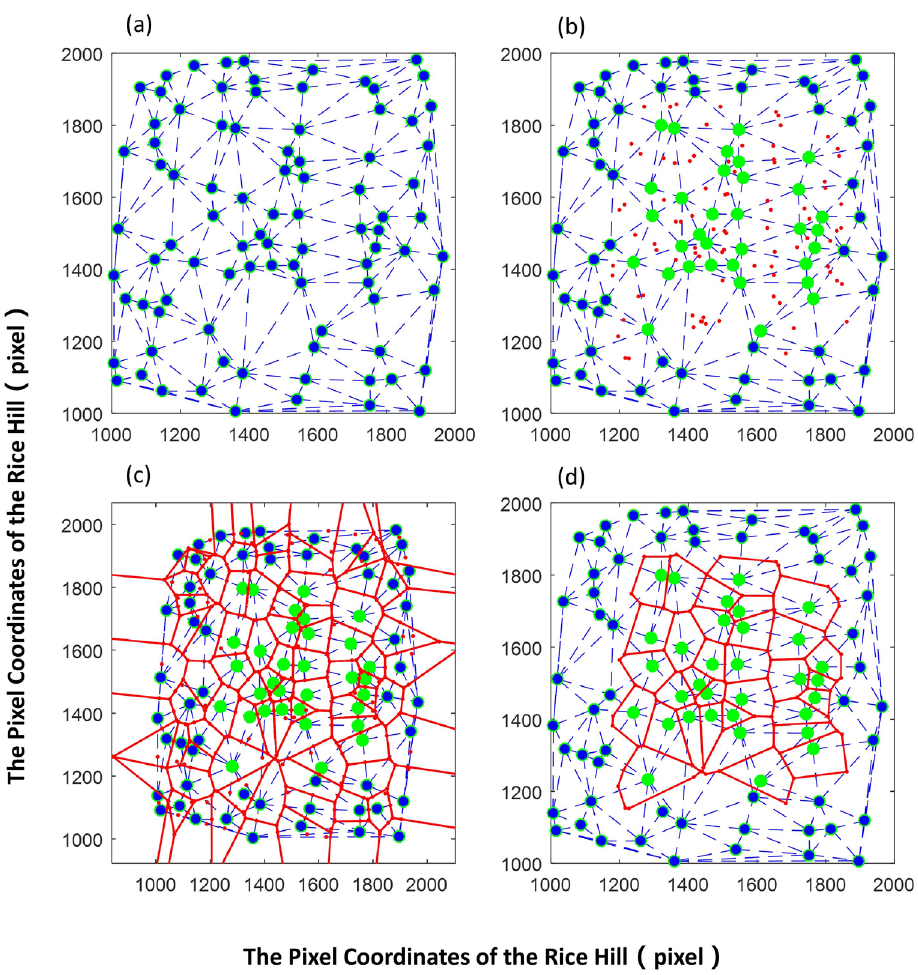
Figure 3. Segmentation process of the region occupied by the rice clusters. ( a ): Segment DT map; ( b ): Segment DT map with part of the outer center of the triangle; ( c ): Segment DT map of the region occupied by rice clusters (full image); ( d ): Segment DT map of the region occupied by the rice clusters (partial image). Large dot—rice cluster; red dot—outer center of the triangle; blue dotted line—edge of the triangle; red solid— borderline of the region occupied by the rice